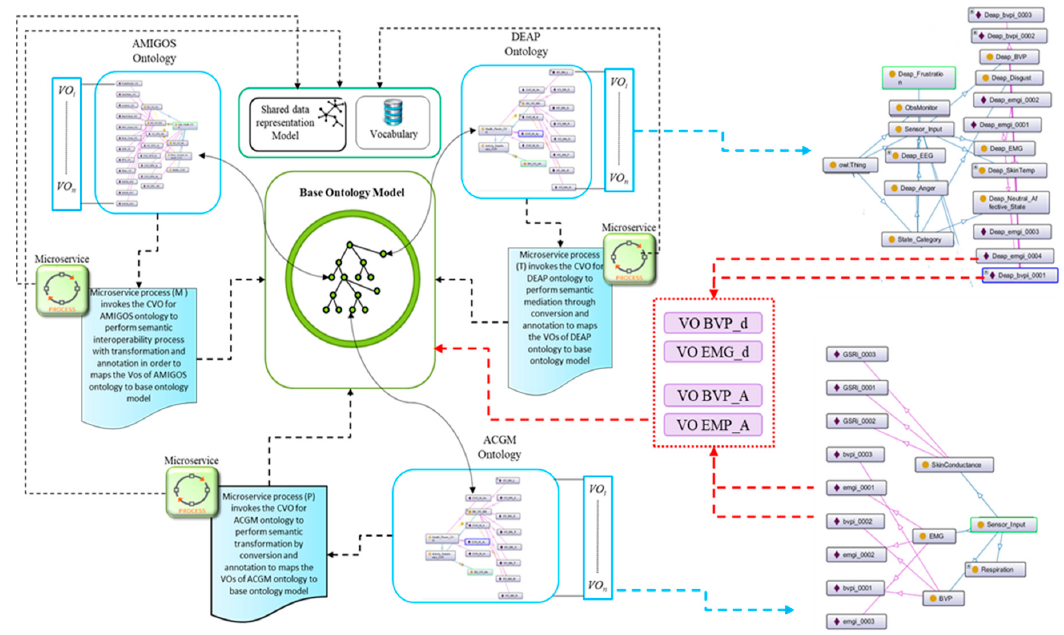
Figure 22. Semantic alignment of ontology models.